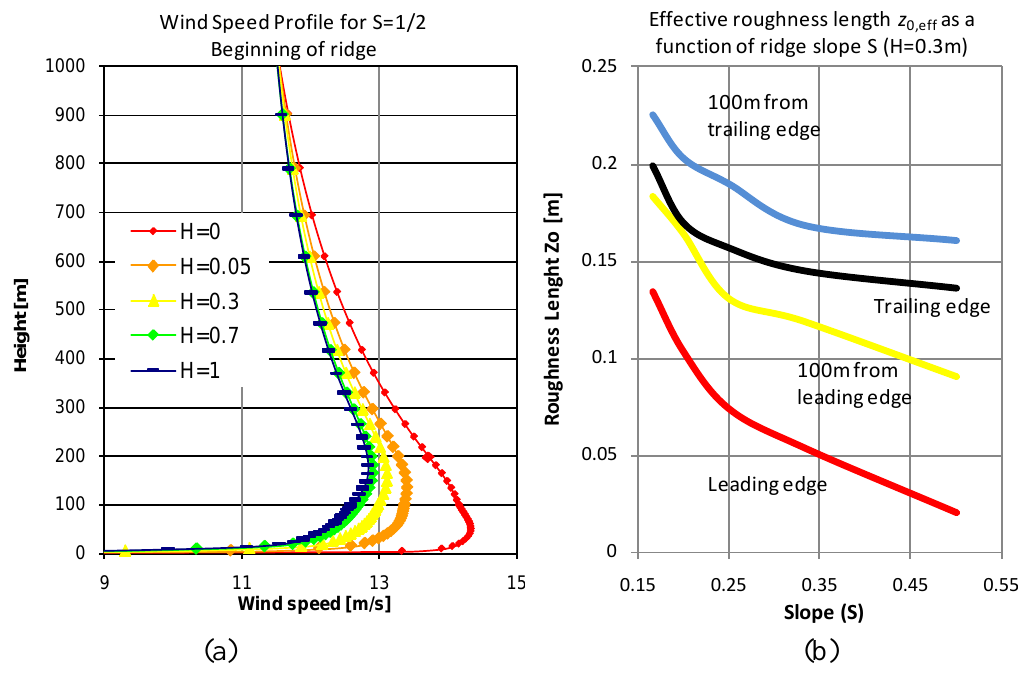
). (b) Effective S = 0.8 m. 0